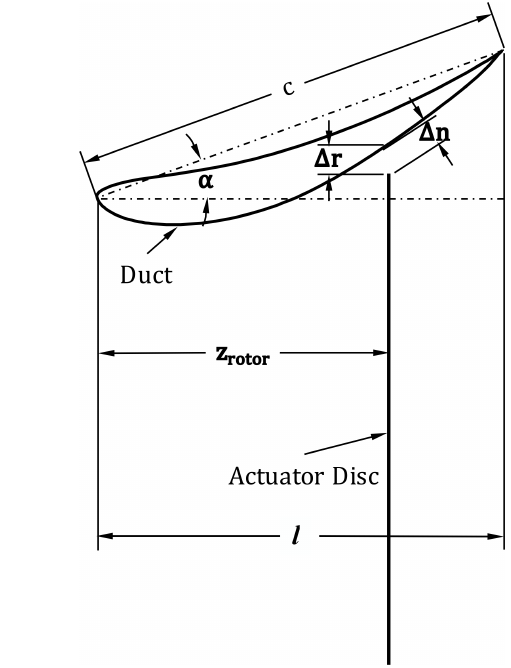
Figure 1. The design variables of a ducted wind